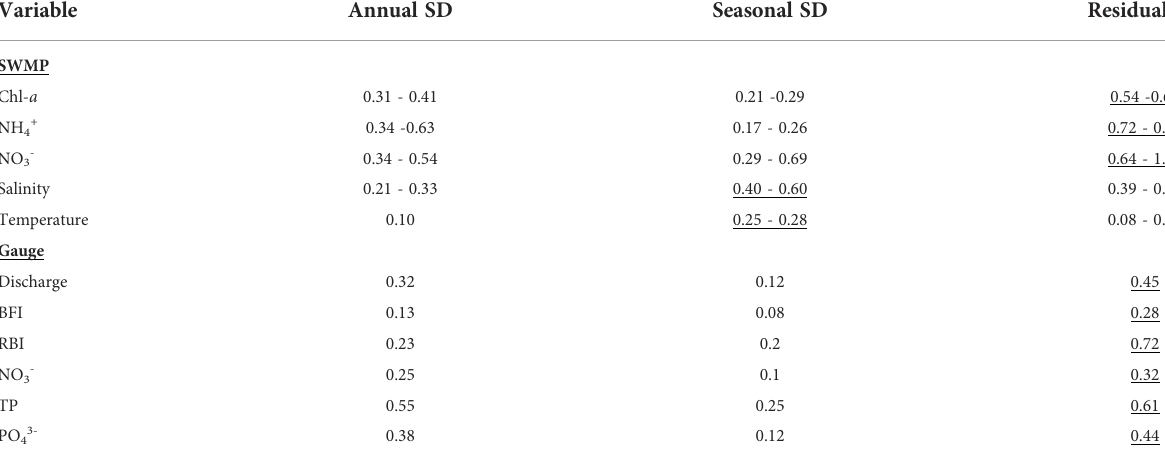
TABLE 2 Variability in decomposition components as the standard deviation (SD) of each component.